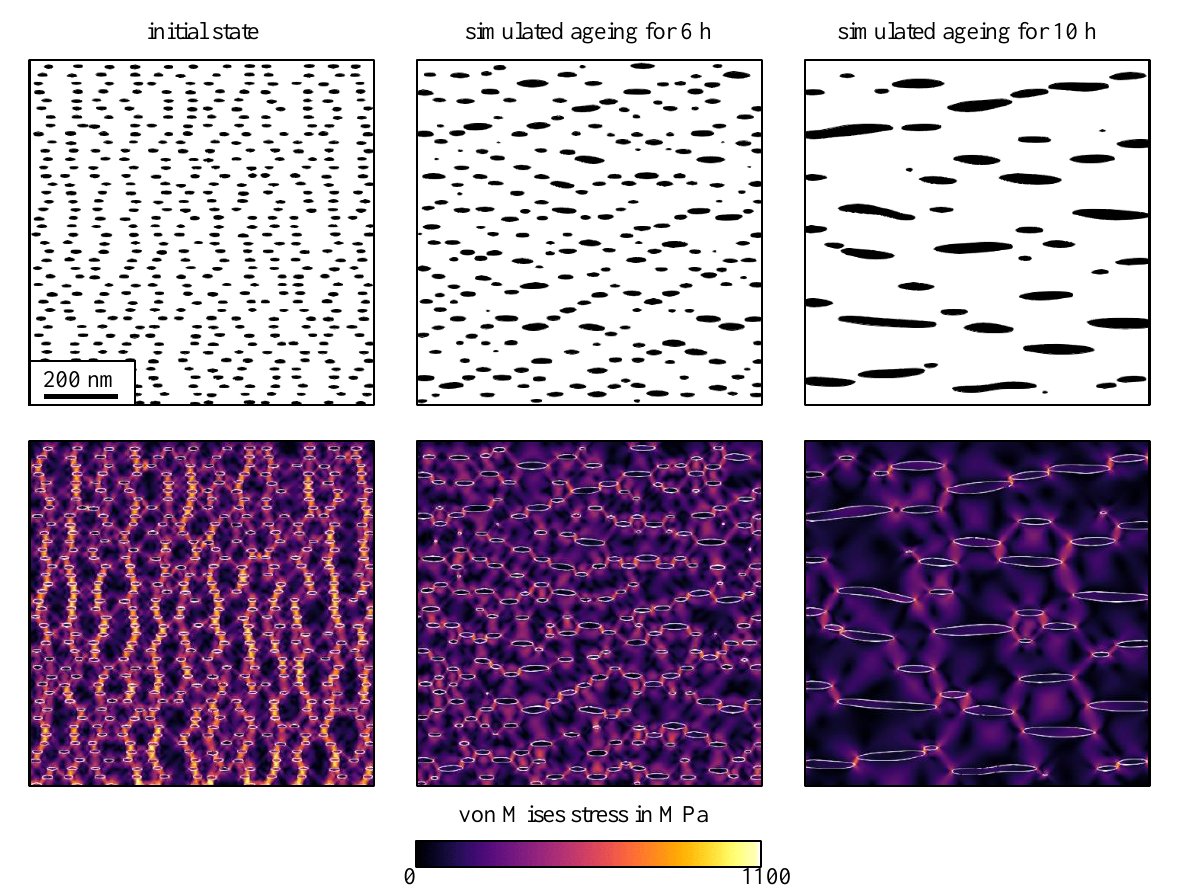
Figure 7. Time series of results from the 2D phase-field simulation of isothermal γ″ particles ripening at 730 °C. In the top row, we show the binarized microstructure, where the particles are indicated in black and the matrix in white. In the bottom row, respective von Mises stress fields are shown. From left to right, we show the initial state, the microstructure after 6 h as well as the microstructure after 10 h.